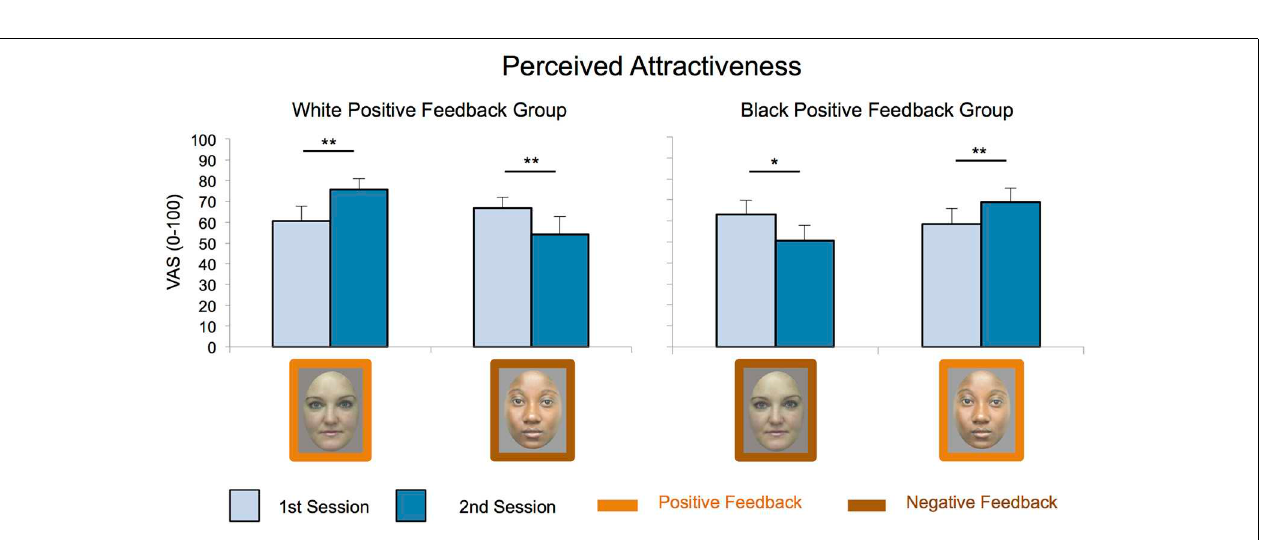
FIGURE 4 | Attractiveness ratings attributed to the partners. Attractiveness ratings (on a 0–100VAS scale with 0 = “minimally attractive” and 100 = “maximally attractive”) increased after participants received positive feedback and decreased after they received negative feedback from